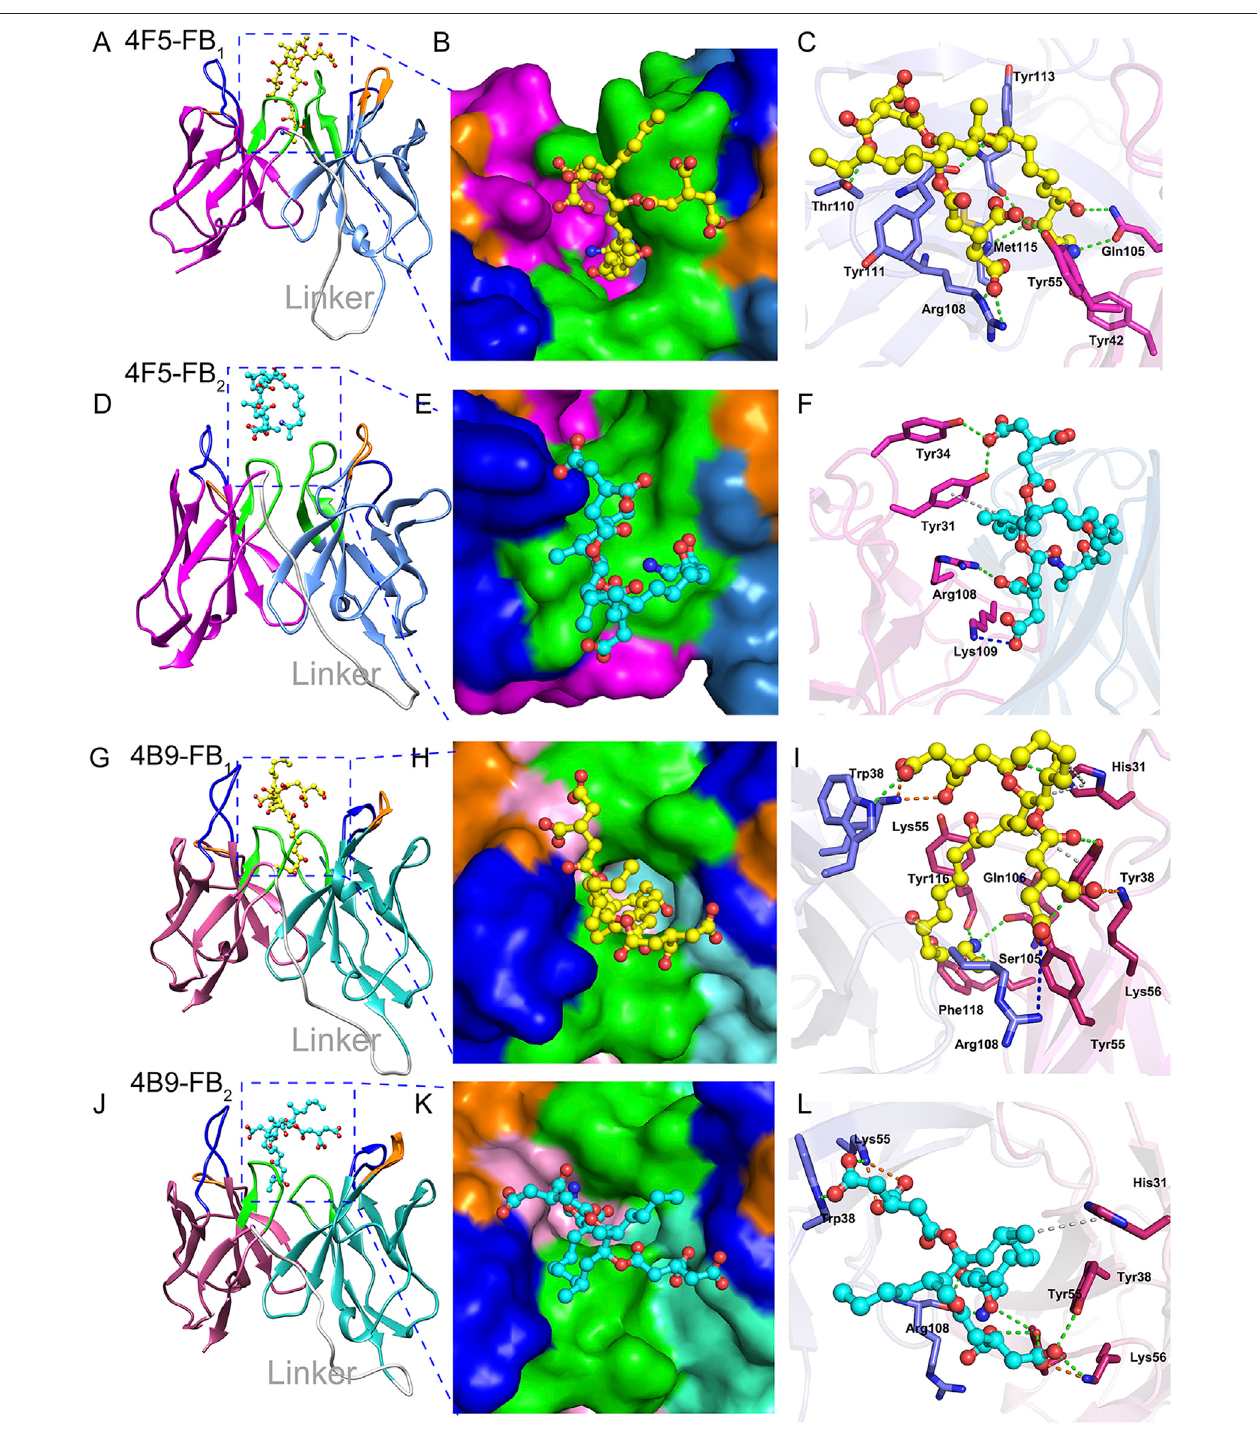
FIGURE5| InteractionanalysisofscFvs-FB s . (A,D) :The4F5-FB 1 complexand4F5-FB 2 complex,marineindicatesVL,magentaindicatesVH,grayindicateslinker, blue indicates CDR1, orange indicates CDR2, greenindicates CDR3. (B,E) : TheFB 1 in thebindingpocket of4F5 scFv and FB 2 inthe binding pocket of4F5 scFv. (C,F) : The interactions between FB 1 and 4F5 scFv, and FB 2 and 4F5; green dashed line indicates the hydrogen bond interaction, blue dashed line indicates the electrostatic attraction, gray indicates the Pi-Alkyl, and orange indicates the salt bridge. (G,J) : The 4B9-FB 1 complex and 4B9-FB 2 complex; hot pink indicates VL, cyan indicates VH, gray indicates linker, blue indicates CDR1, orange indicates CDR2, green indicates CDR3. (H,K) : FB 1 in the binding pocket of 4B9 scFv and FB 2 in the binding pocket of 4B9 scFv. (I,L) : The interactions between FB 1 and 4B9 scFv, and FB 2 and 4B9; green dashed line indicates the hydrogen bond interaction, blue dashed line indicates the electrostatic attraction of pi-cation and attractive charge, gray indicates the pi-Alkyl, and orange indicates the salt bridge.